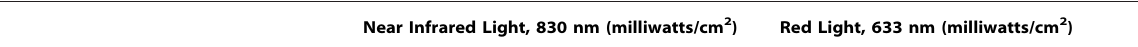
Air only, at a distance of 10 mm Cheek, Light Pressure